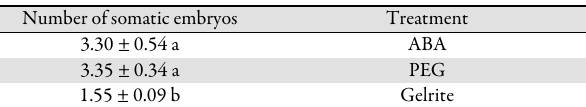
Table 2. Effects of osmo-regulators on somatic embryos number